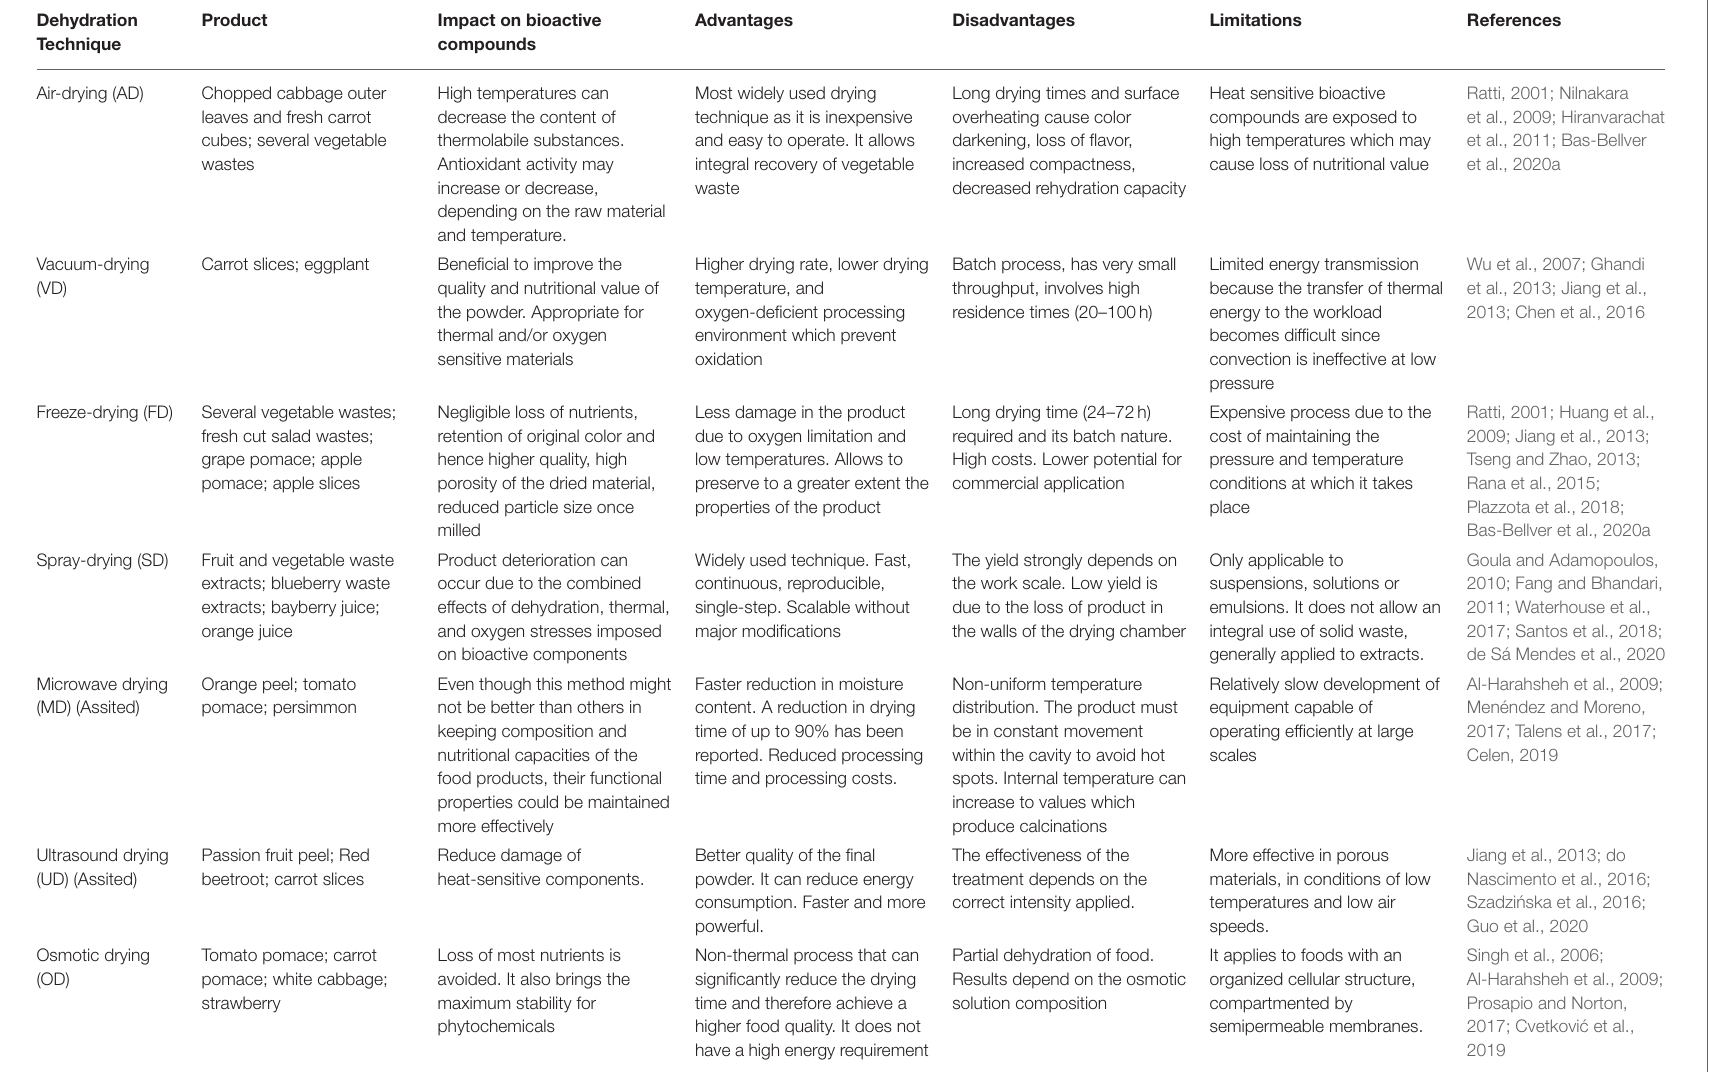
TABLE 1 | Main dehydration techniques available for the development of functional ingredients and foods. Dehydration